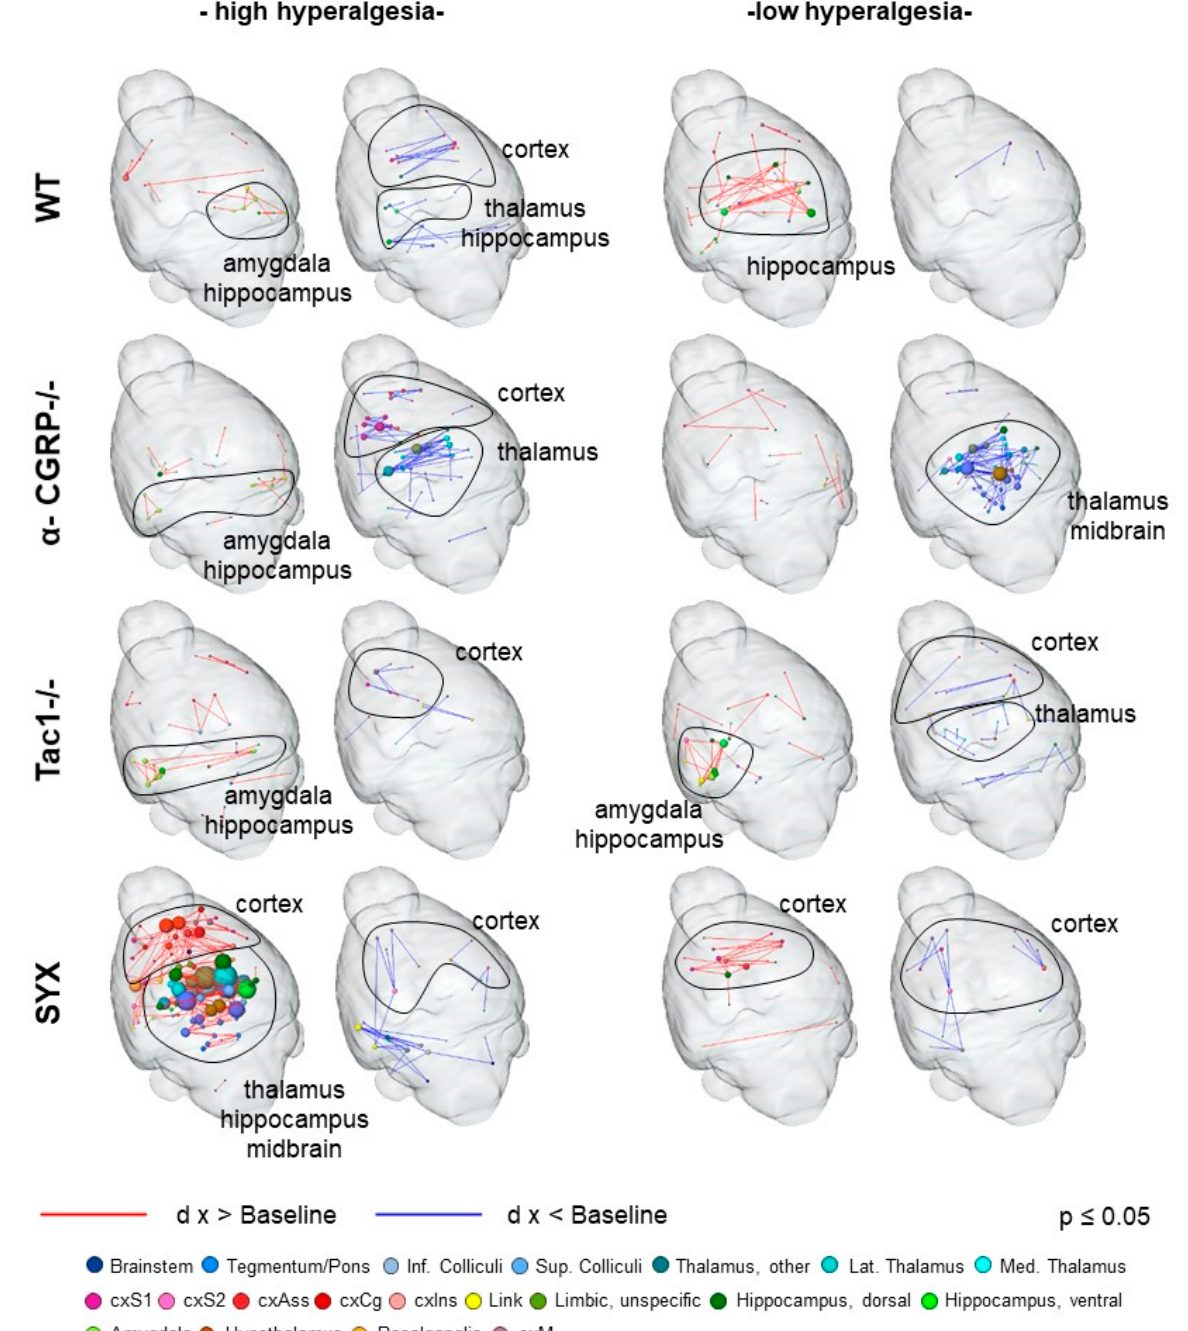
Figure 6. Enhanced amygdala and hippocampal connectivity reflected fracture-induced hyperalgesia evoked by nociceptive thermal stimulation of the hind paw of the fractured leg (noxious heat 50 and 55 °C, left paw). Red edges reflect enhanced and blue edges reflect decreased nociceptive FC at day 5 or day 21 after fracture, respectively, compared to baseline. Color-coded nodes represent the different brain regions, with the size of the nodes reflecting the degree, i.e., how many connections this node has to other unconnected nodes are omitted. Abbreviations: cxS1 (primary somatosensory cortex), cxS2 (secondary somatosensory cortex), cxAss (association cortex), cxCg (cingulate cortex), cxIns (insular cortex), cxM (motor cortex), inf. (inferior), lat. (lateral), med. (medial), sup. (superior). (nWT = 13, nCGRP − / − = 9, nTac1 − / − = 9, nSYX =